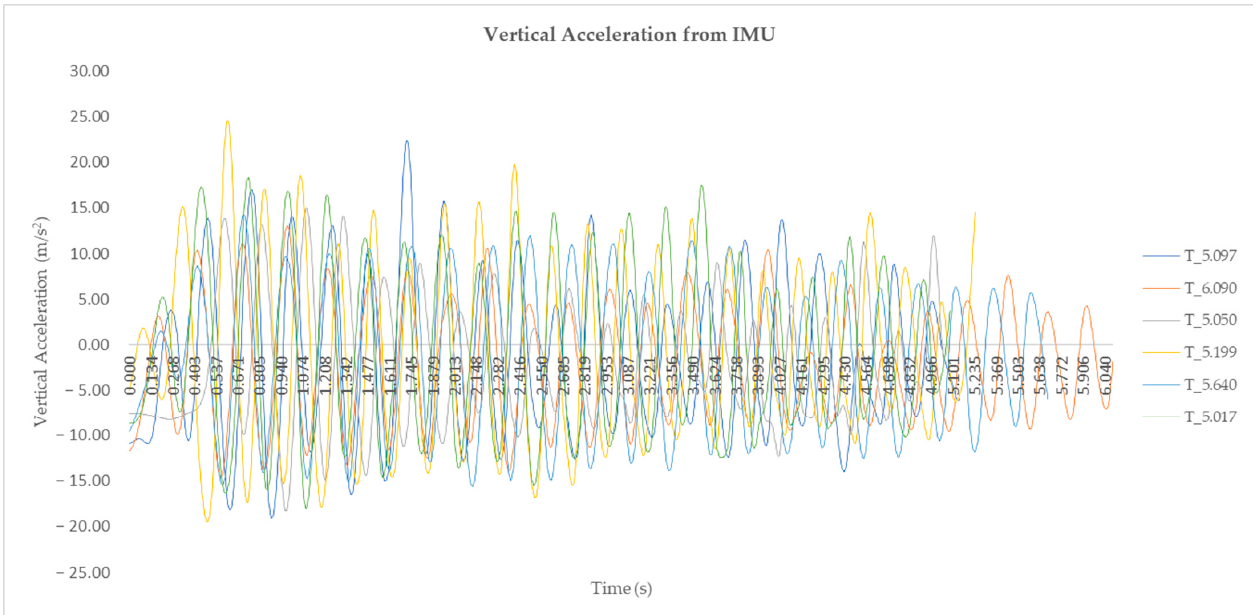
Figure 6. The vertical acceleration results from the IMU for the best performance over 40 m for athlete 1, athlete 2, athlete 3, athlete 4, athlete 5, and athlete 6.